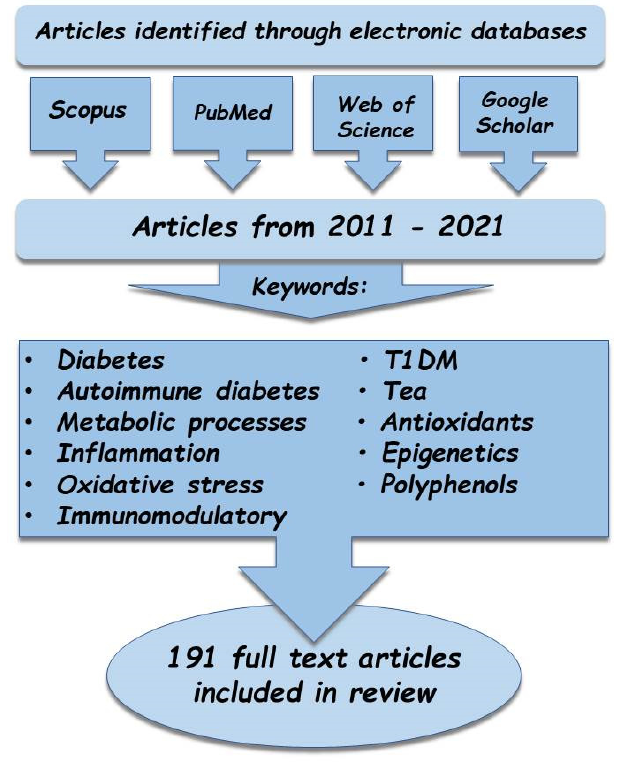
Figure 1. Research strategy employed in the review of the available